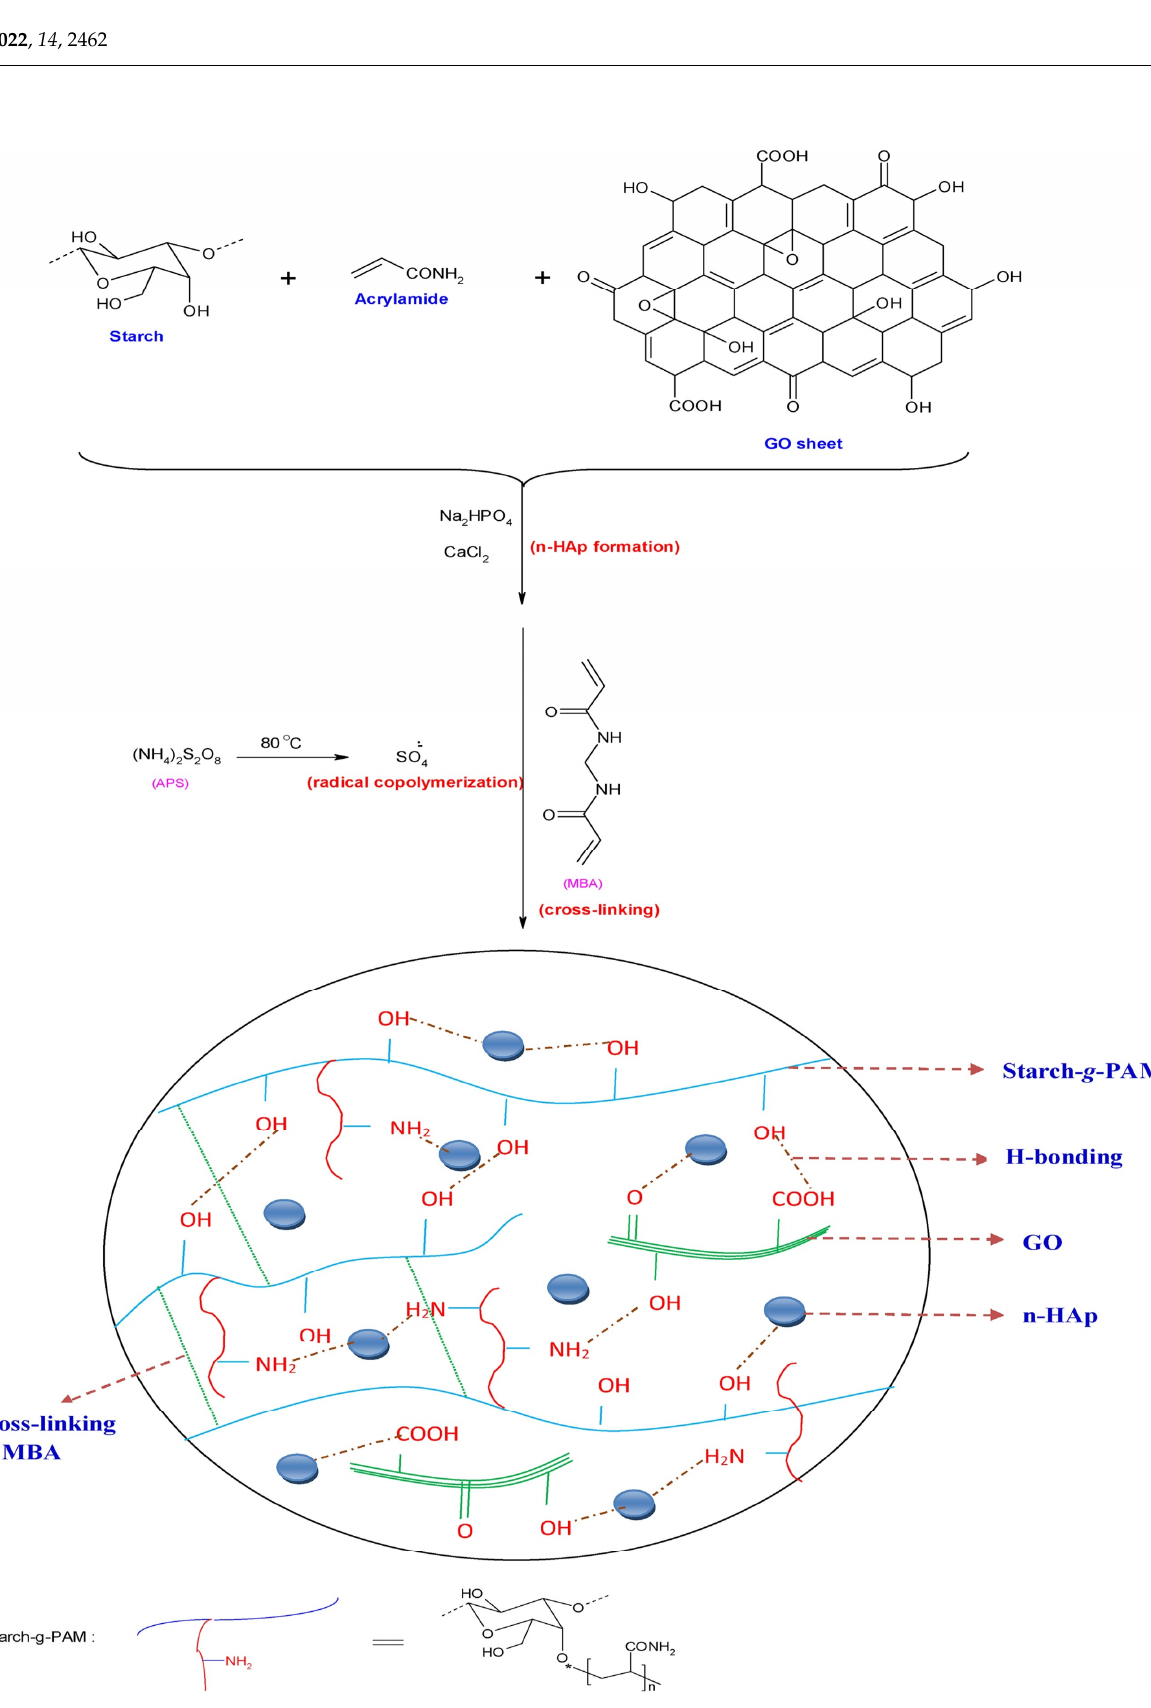
Figure 7. Hydrogel adsorbent with starch-graft-poly(acrylamide)/graphene oxide/hydroxyapatite nanocomposite as constituent. Adapted from Hosseinzadeh and Ramin [80].